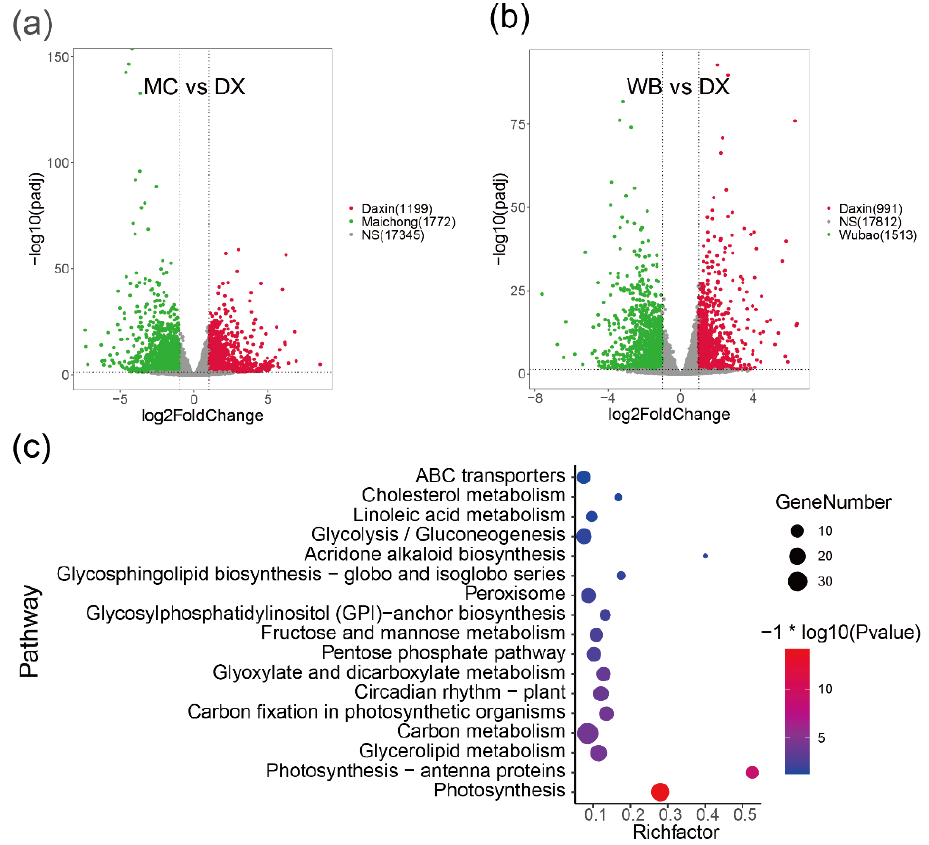
Figure 2. Volcano plots of DEGs in the pairwise comparisons and pathway enrichment. ( a ) Volcano plot of DEGs in the MC vs. DX comparison. Green dots represent genes up-regulated in Maichong. Red dots represent genes up-regulated in Daxin. Grey dots represent genes that show no significant difference between two orchards. ( b ) Volcano plot of DEGs in the WB vs. DX comparison. Green dots represent genes up-regulated in Wubao. Red dots represent genes up-regulated in Daxin. Grey dots represent genes that are not significantly different between two orchards. ( c ) Pathway enrichment of genes co-up-regulated in MC and WB. The pathway with p value ≤ 0.05 are shown. Node size represents the number of differential genes within the pathway and color represents the significance of the pathway. ‘Gene number’ is the number of genes enriched in a pathway. ‘Rich factor’ is the percentage of total DEGs in the given pathway